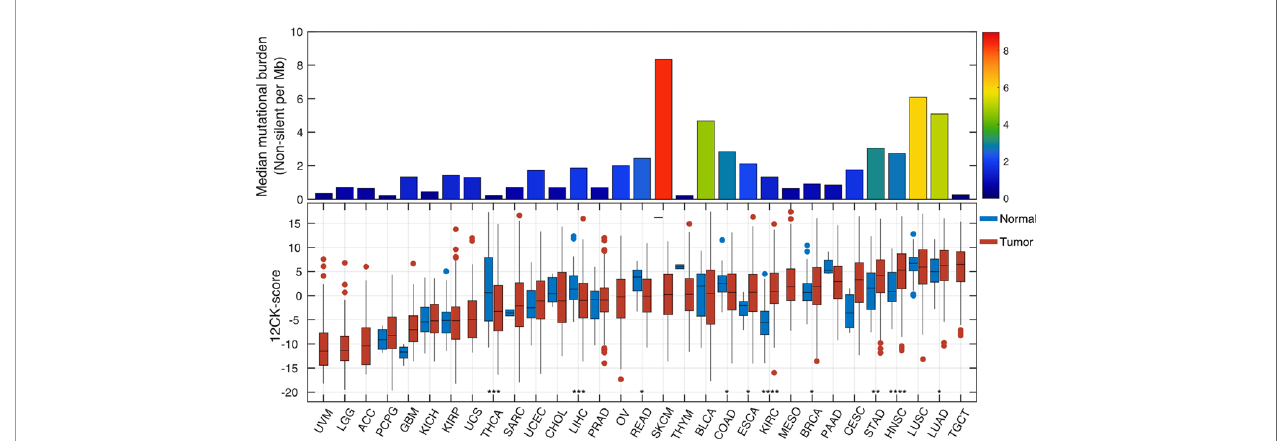
FIGURE 1 | Pan-cancer analysis of the 12-chemokine score. The 12-CK score was extracted from the RNA expression data from various tumor types within The Cancer Genome Atlas, along with expression levels in matched normal samples and their non-silent tumor mutational burden (TMB). In general, 12-CK scores corresponded with TMB. ACC, adrenocortical carcinoma; BLCA , bladder carcinoma; BRCA , breast carcinoma; CESC, cervical squamous carcinoma; CHOL , cholangiocarcinoma; COAD, colon adenocarcinoma; ESCA , oesophageal carcinoma; GBM, glioblastoma; HNSC, head and neck squamous cell carcinoma; KICH, kidney chromophobe; KIRC, kidney renal clear- cell carcinoma; KIRP, kidney renal papillary cell carcinoma; LGG, lower- grade glioma; LIHC, liver hepatocellular carcinoma; LUAD, lung adenocarcinoma; LUSC, lung squamous cell carcinoma; MESO, mesothelioma; OV, ovarian serous cystadenocarcinoma; PAAD, pancreatic adenocarcinoma; PCPG, pheochromocytoma and paraganglioma; PRAD, prostate adenocarcinoma; READ, rectum adenocarcinoma; SARC, sarcoma; SKCM, skin cutaneous melanoma; STAD, stomach adenocarcinoma; TGCT, testicular germ cell tumor; THCA , thyroid carcinoma; UCEC, uterine corpus endometrial carcinoma; UCS, uterine carcinosarcoma; UVM, uveal melanoma. *p < 0.05, **p < 0.01, ***p < 0.001, ****p <